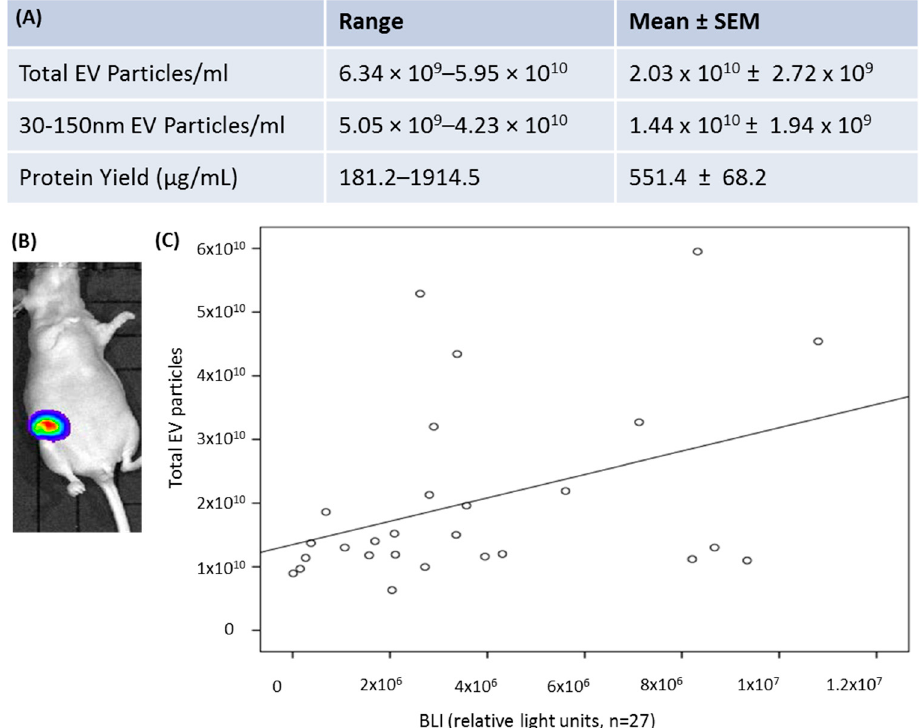
Figure 3. ( A ) EV yield as determined by nanoparticle tacking analysis, and protein yield, as detected by microBCA assay from the sera of HCC-1954-luc tumour-bearing mice. ( B ) Sample bioluminescent IVIS image from a mouse bearing mammary fat pad tumour; ( C ) relationship between BLI (relative light units) and number of circulating EVs.